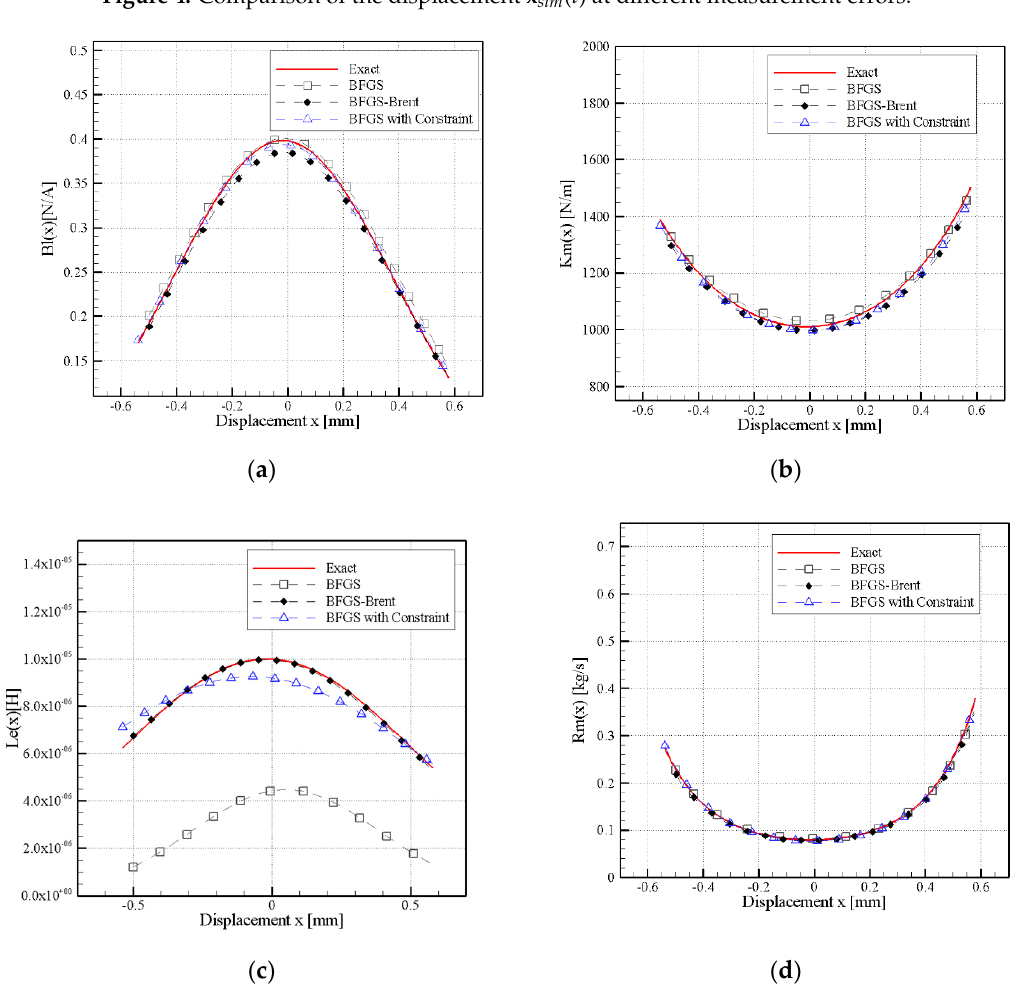
σ σ on nonlinear parameters, ( a ) Bl ( x ), ( b ) K m ( x ), ( c ) L e ( x ), on nonlinear parameters, ( a ) Bl ( x ), ( b ) K m ( x ), ( c ) L e ( x ),